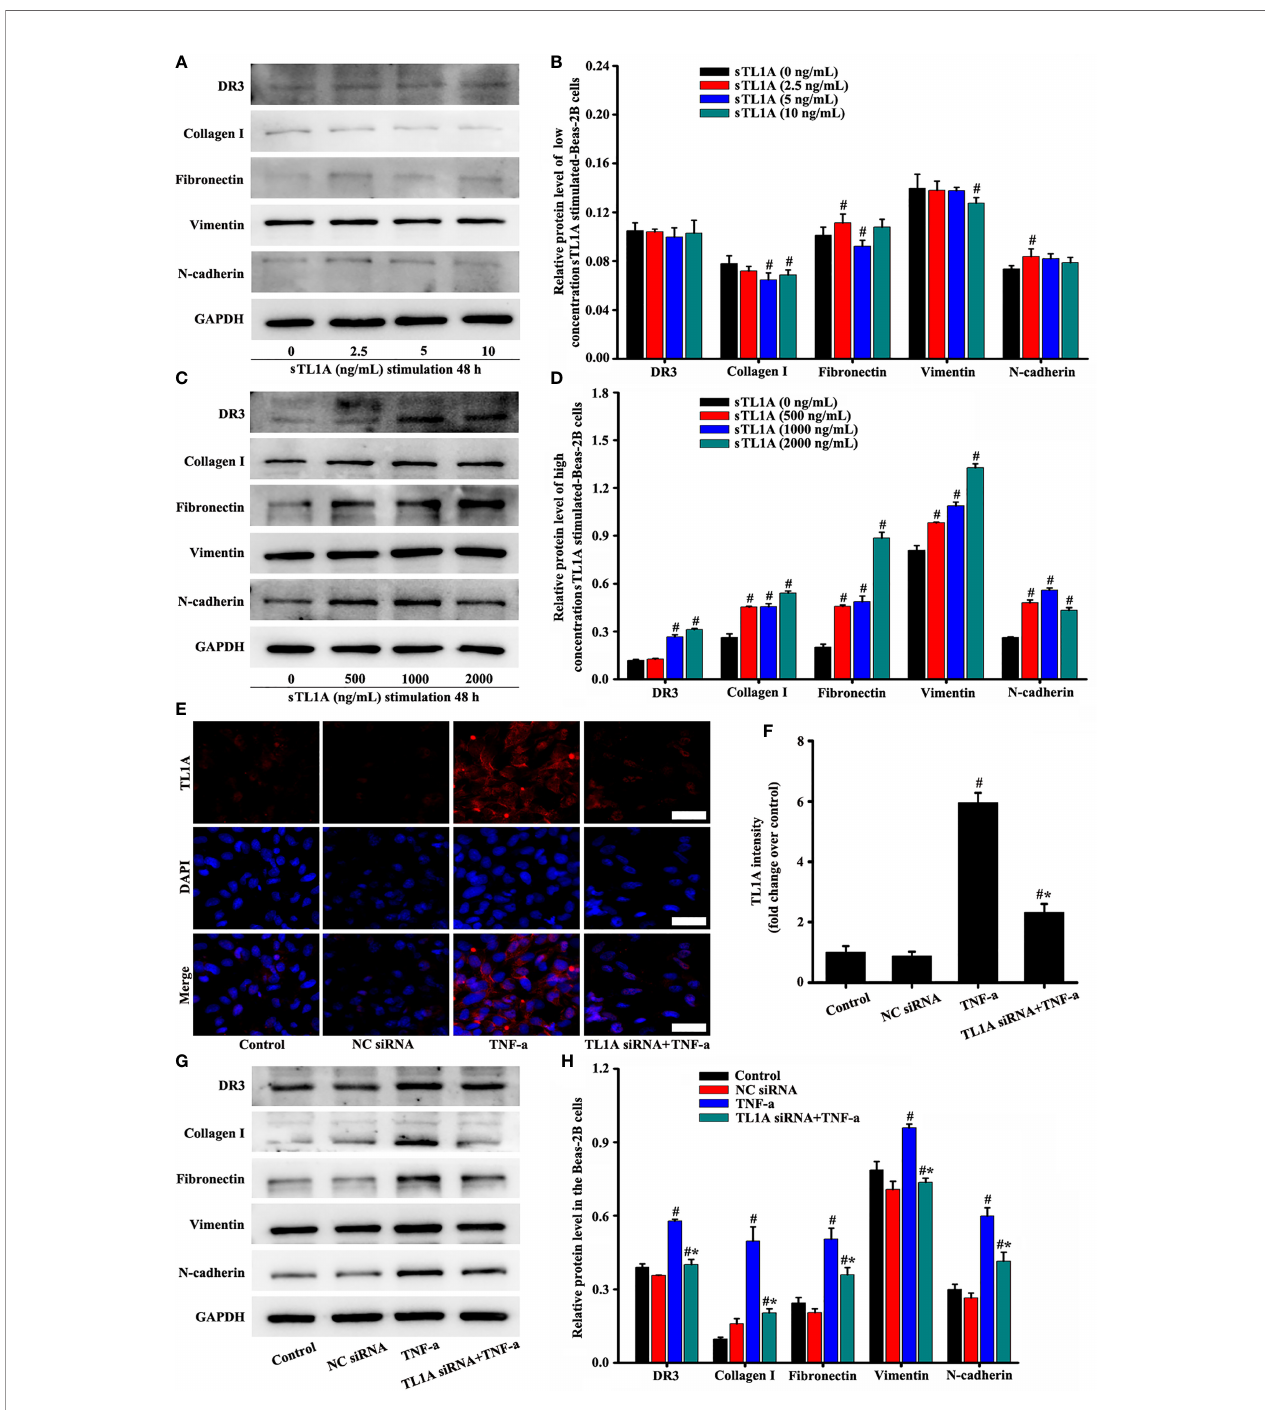
FIGURE 8 | Effects of the TL1A/DR3 axis on the EMT in Beas-2B cells were detected. TNF-a (50 ng/mL) stimulation for 48 h as the best cell model based on the above experimental results. The effect of sTL1A on EMT was detected by Western blotting (A, C) . The effects of TL1A siRNA on TL1A induced by TNF-a were detected by immuno fl uorescence (E) . Effects of TL1A siRNA on the EMT formation induced by TNF-a were measured by Western blotting analysis (G) . (E) : magni fi cation 200 ×, scale bar 50 µm. (B, D, F, H) intensity analysis of (A, C, E, G), respectively. Data are expressed as the means ± SD for three independent experiments. # p < 0.05 versus the control group. # *p < 0.05 versus the TNF-a